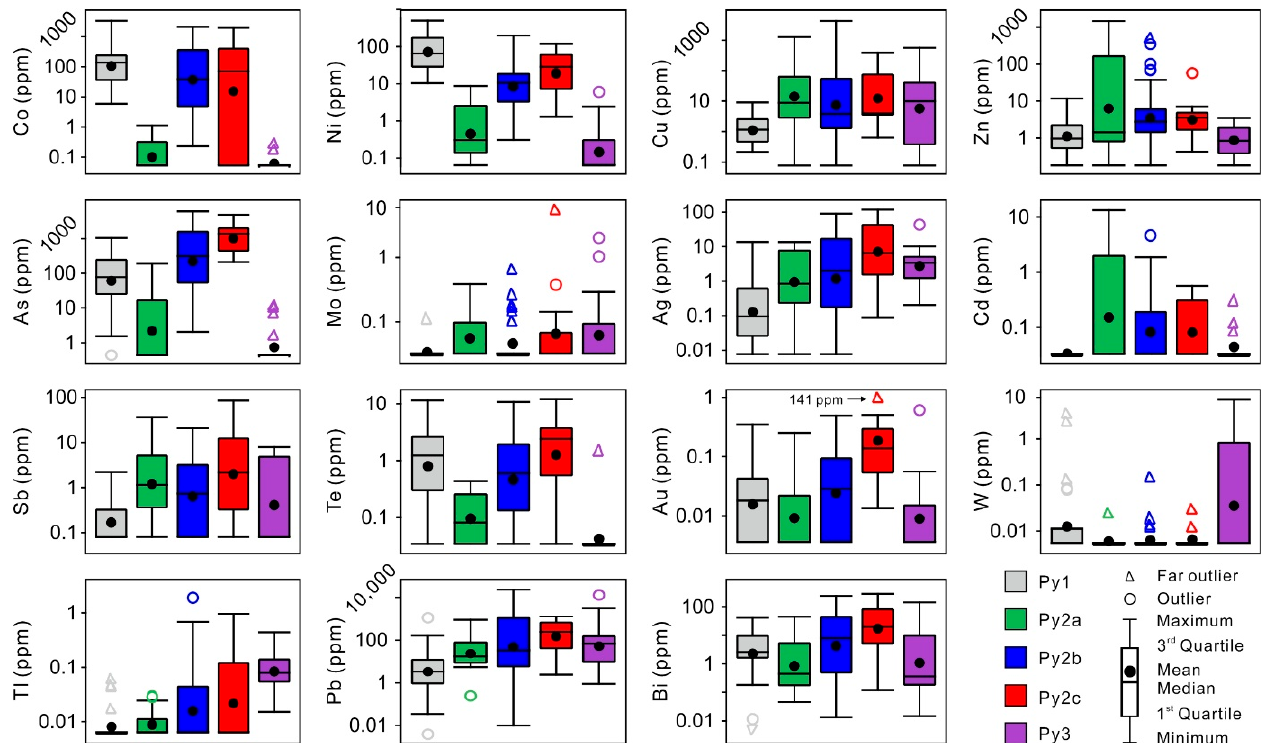
Figure 7. Comparative box-whisker plots showing the concentration of representative trace elements measured by laser ablation–inductively coupled plasma mass spectrometry (LA–ICP–MS) in pyrite from the Sizhuang gold deposit.